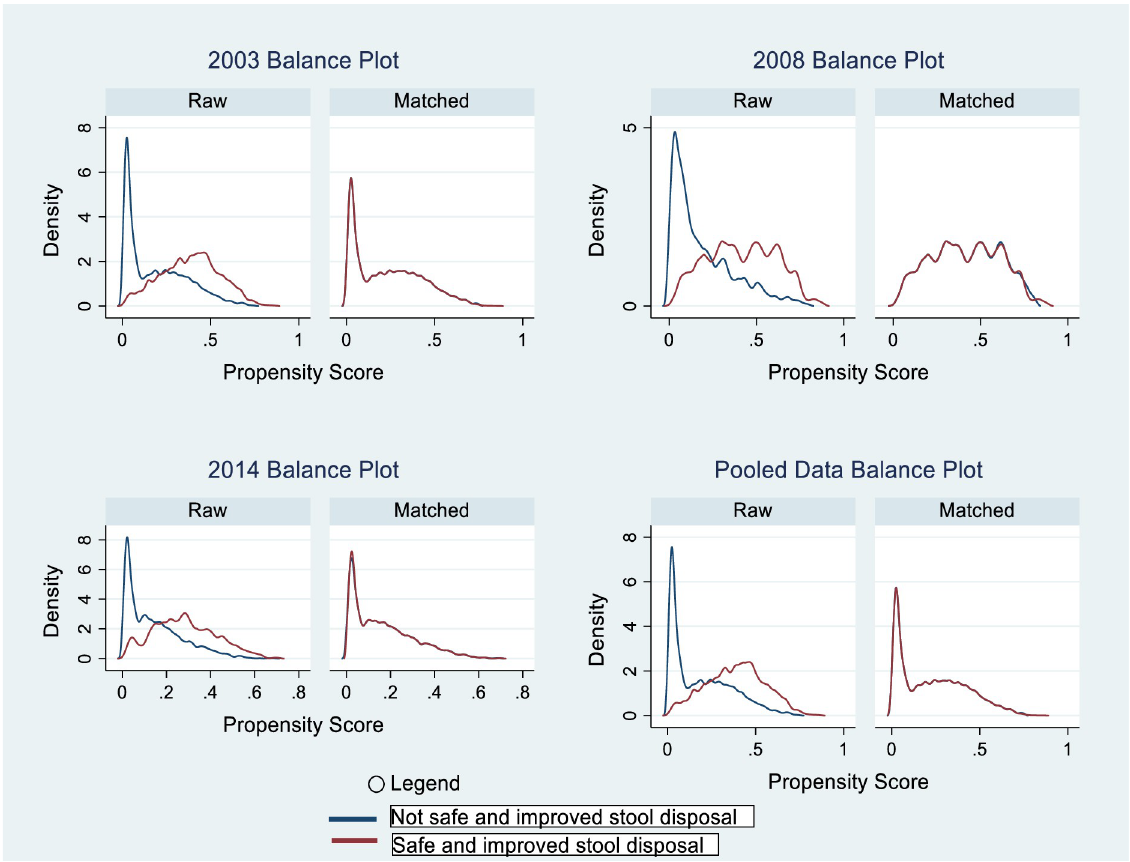
Fig 1. Imbalance and balancing result showing the analytical test of the Kernel-based propensity score matching for covariates associated with access to hygienic disposal of stools among women with children under two years in Ghana, GDHS 2003–2014.